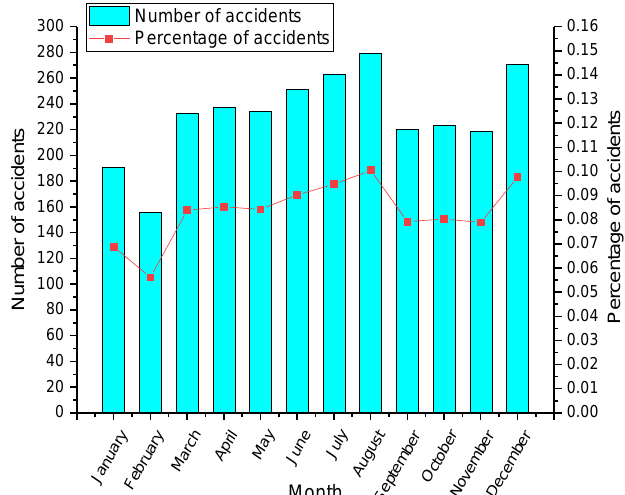
Figure 2. Distribution of accidents by months. Int. J. Environ. Res. Public Health 2022 , 19 , x FOR PEER REVIEW